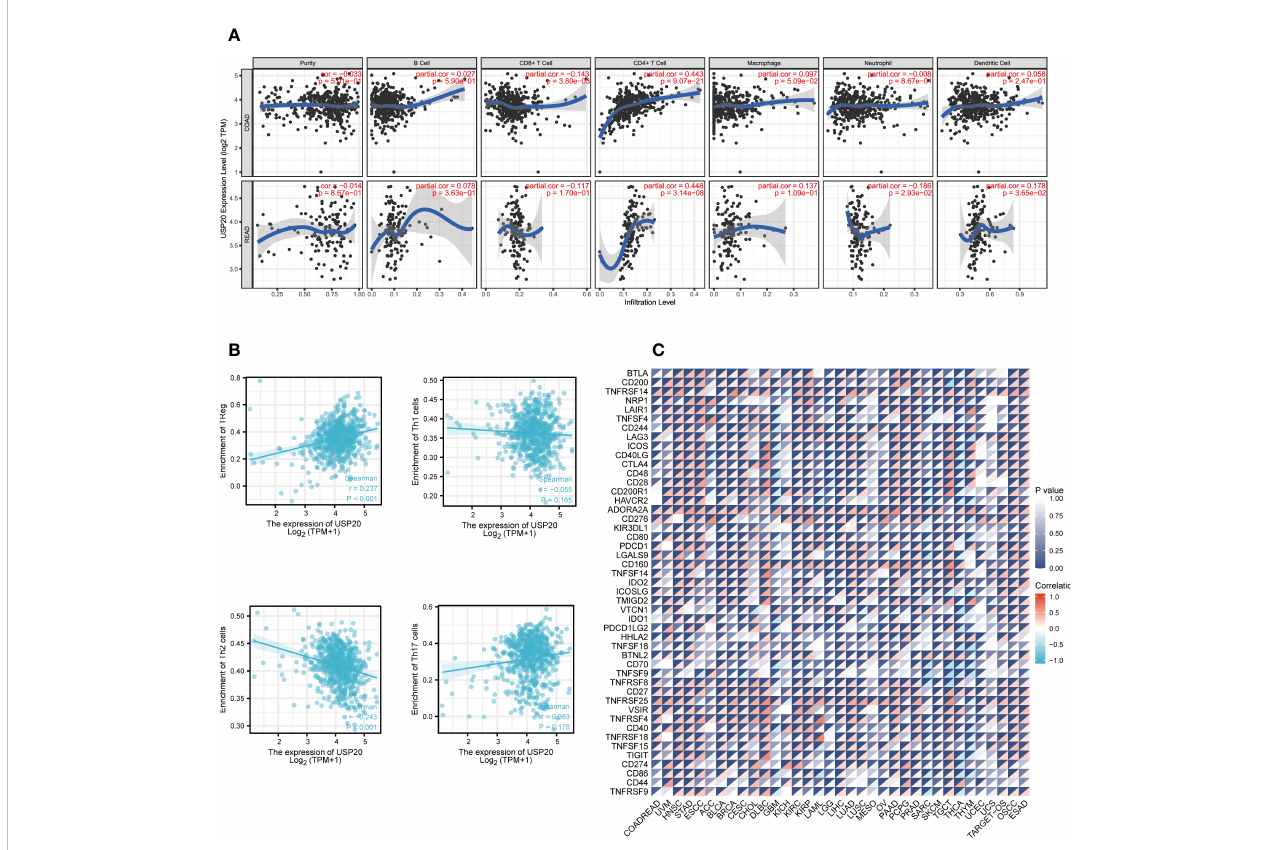
FIGURE 5 Correlation between immune and USP20 expression in CRC; (A) Using TIMER database to analyze the correlation between gene expression and immune cell scores (B) Using ssGSEA method to calculate the correlation between USP20 and CD4 + T cell subsets; (C) Correlation analysis of USP20 expression in pan-cancer with immune checkpoint gene